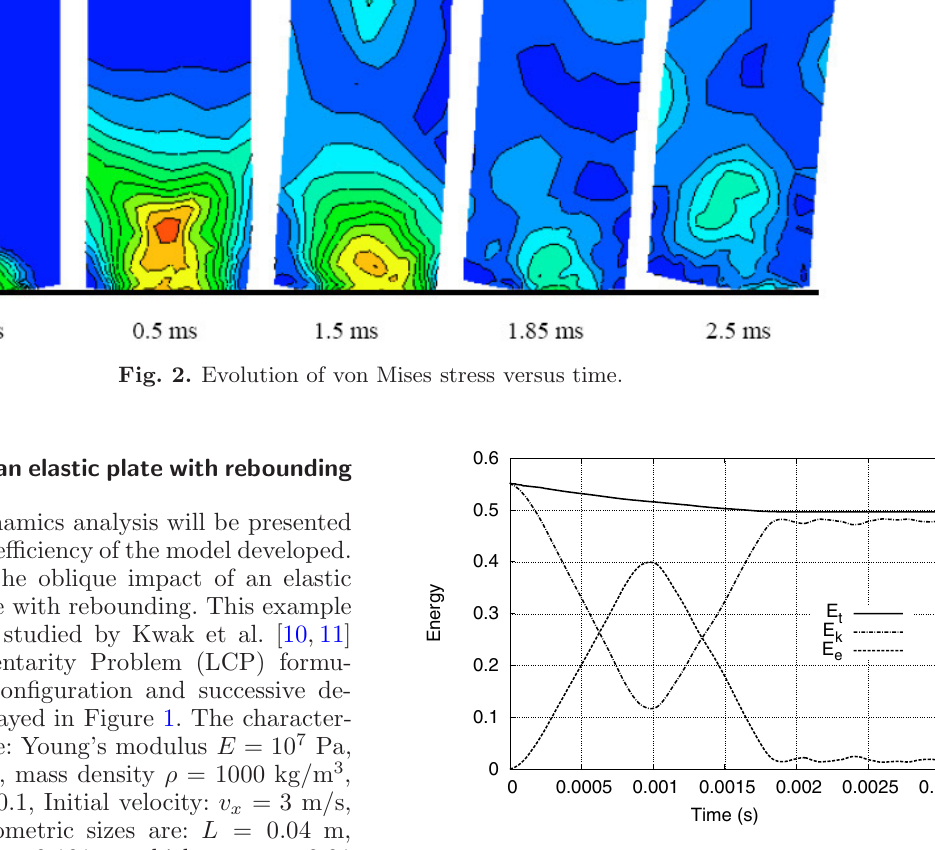
Fig. 3. Energy evolution with